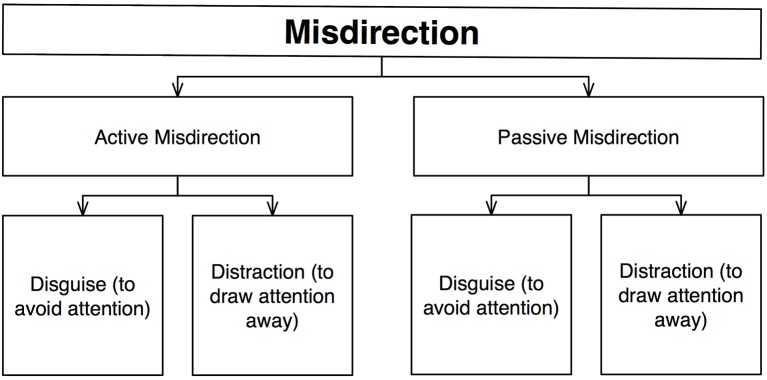
Schematic diagram of Sharpe's (1988) taxonomy.